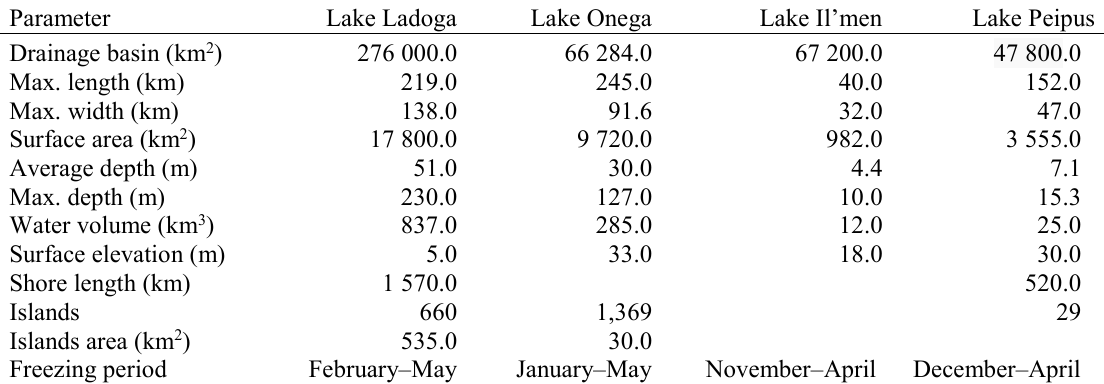
Table 1 Physical geographic parameters of the northwest Russian lakes.